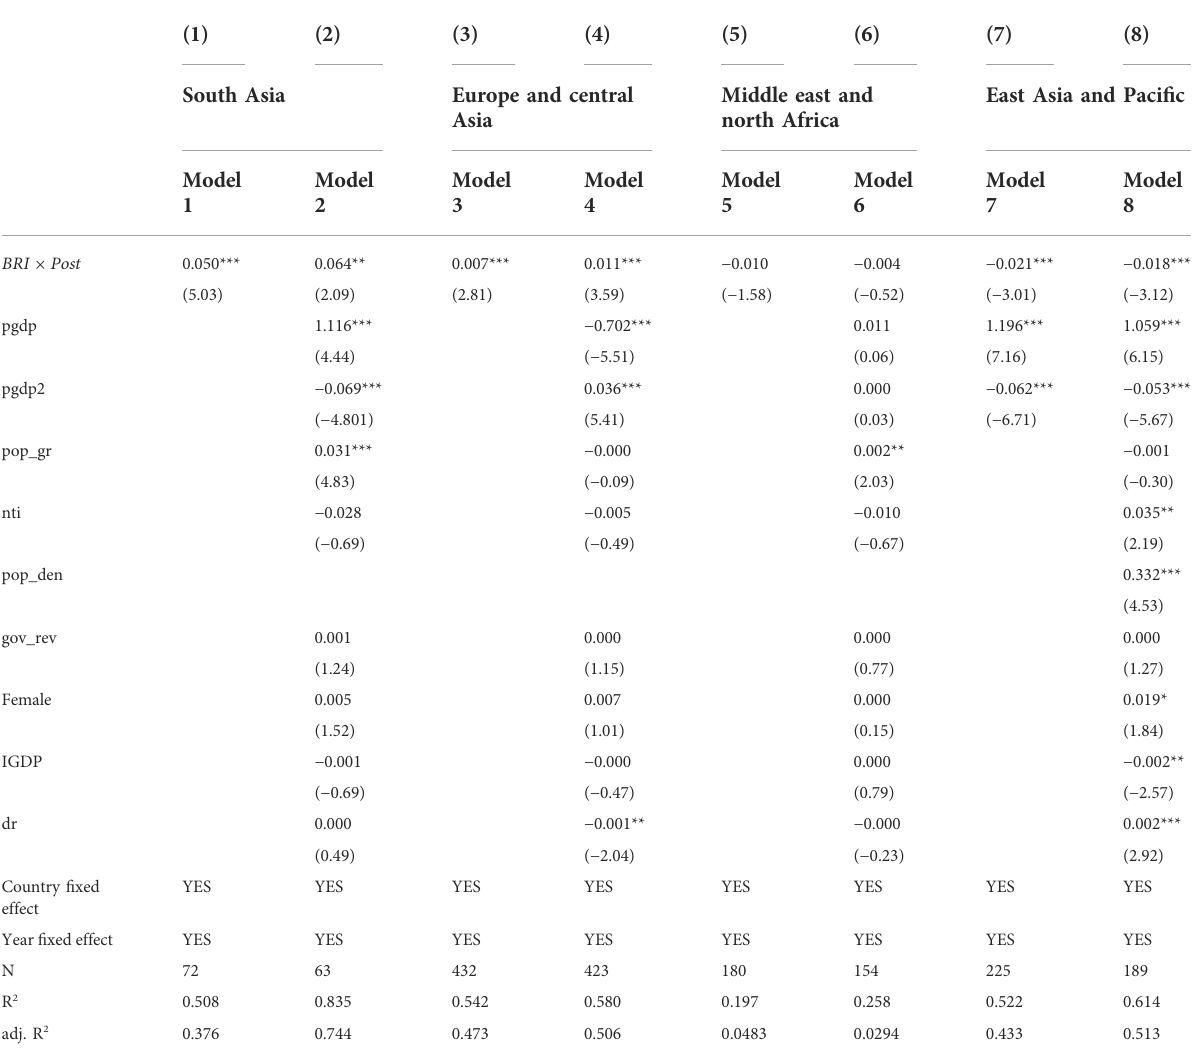
TABLE 11 Effects of the Belt and Road Initiative on environmental quality: Economic-geographical